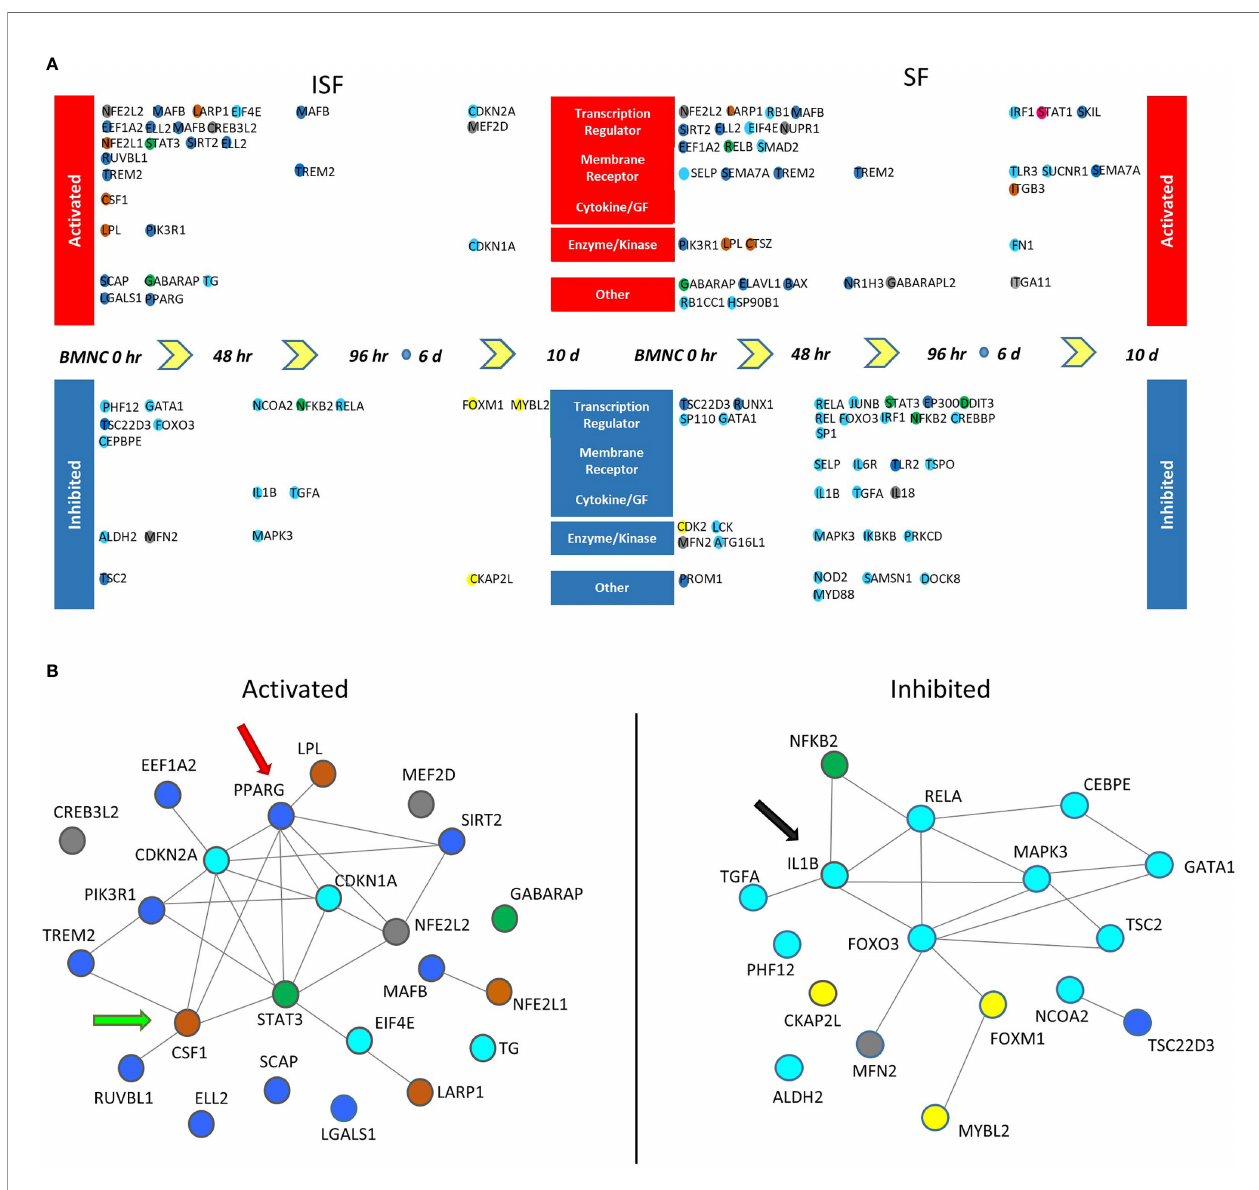
FIGURE 7 | Potential upstream regulators of genes differentially expressed between consecutive time points (DEGcts) in SF and ISF cultures. (A) Time window speci fi c identi fi cation of upstream regulators analysis of the DEGcts using Ingenuity Pathway Analysis (IPA). The colored circles are upstream regulators identi fi ed for each comparison of consecutive time points with an activation or inhibition Z-score ( > 2.0 or < -2.0), respectively ( Supplementary Table 5 ). Colors of the circles correspond to colors of the module eigengene from WGCNA to which that speci fi c gene associated. Activated upstream regulators are shown at the top and those inhibited at the bottom. Upstream regulators were grouped into fi ve categories: `Transcription regulator ’ , `Membrane receptor ’ , `Cytokine/Growth Factor (GF) ’ , ‘ Enzyme/Kinase ’ and `Other ’ . (B) Interaction network among activated (left) and inhibited (right) upstream regulators in BMNC cultured in ISF. Color coding of nodes relate to the corresponding module eigengene. Interaction networks re fl ect a response to in fl ammation-induced oxidative stress associated with proliferation and differentiation of BMNC into macrophages (CSF1 - green arrow), and a PPAR g -reliant in fl ammation resolution (red arrow), associated with inhibition of the IL-1 b signaling pathway (black arrow) as suggested by complimentary